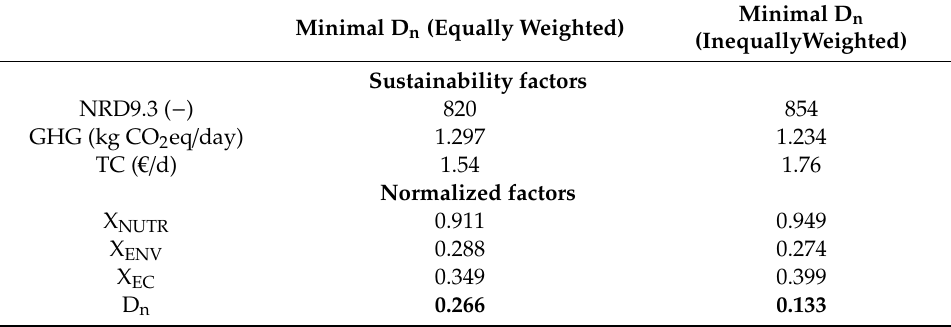
Table A3. Factors for all optimized diet scenarios without